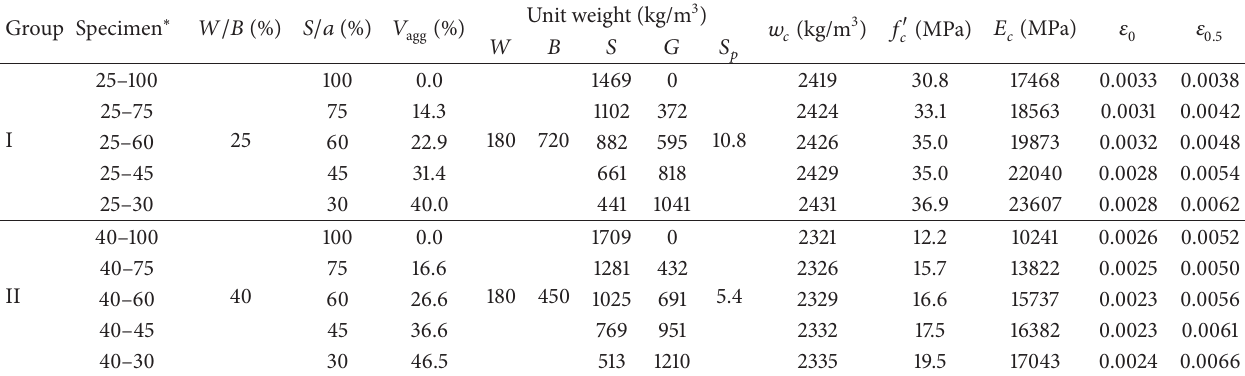
Table 2: Details of Ca(OH) -activated Hwangtoh concrete mix proportions and summary of test results. 2 Group Specimen